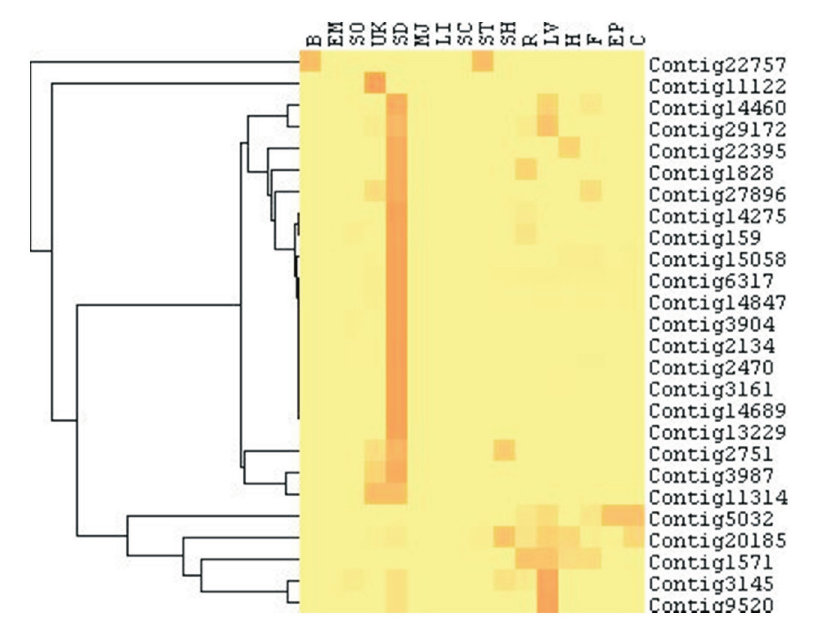
Figure S2 - PR-2 expression profile in 16 different libraries from